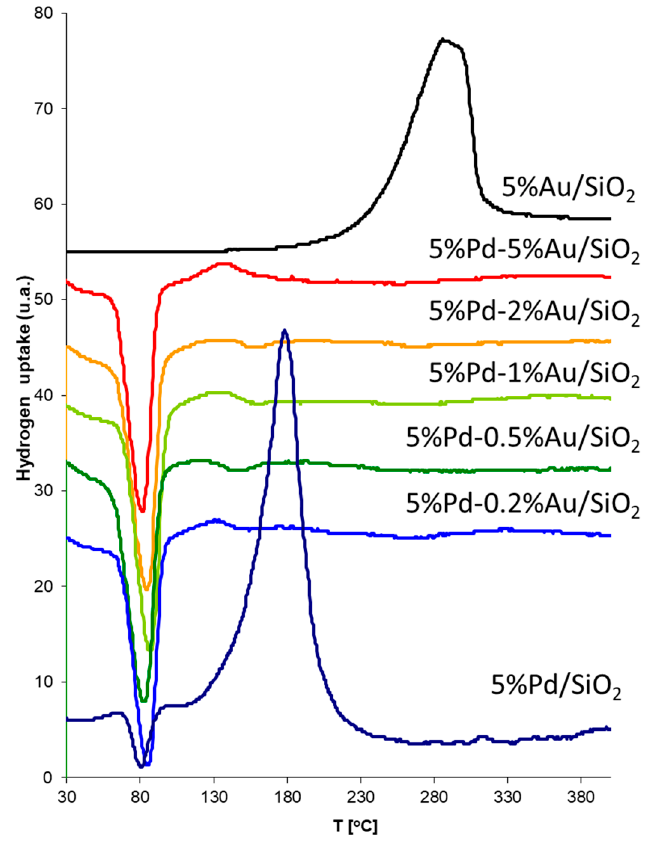
Figure 10. Temperature programmed reduction (TPR) of Pd-Au / SiO 2 catalysts after co-impregnation step. The catalyst samples (0.1 g), prior to the TPR measurements were flushed with argon at the room temperature for 0.5 h. TPR runs were performed in the temperature range 25–500 ◦ C, using a mixture of hydrogen-argon (5 vol.% of H 2 ) and a linear temperature growth of 20 ◦ C / min. The flow rate of gases was 30 cm 3 /min.